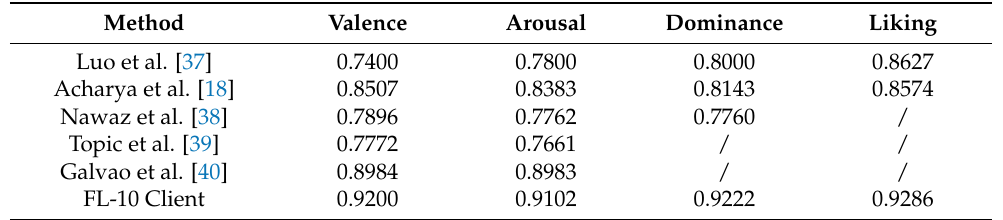
Table 5. Comparison with state-of-the-art techniques using the same DEAP EEG dataset for the emotion recognition